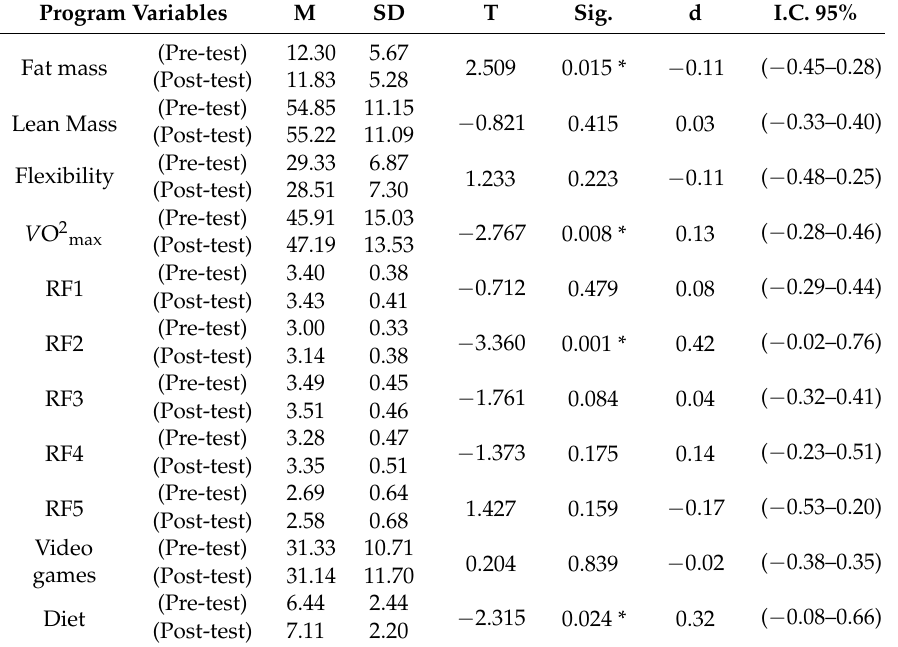
Table 3. Effect of the intervention program on the variables studied.